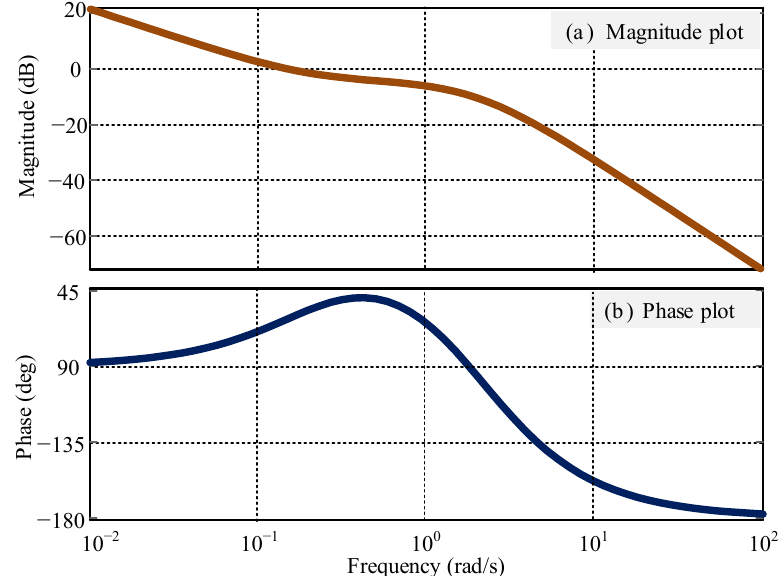
Figure 13. Stress voltage waveforms of the IGBTs and diodes used in the proposed transformer-less inverter: ( a ) S 1 , ( b ) S 2 , ( c ) S 3 , ( d ) S 4 , ( e ) S 5 , ( f ) S 6 , ( g ) S 7 , ( h ) D 1 , ( i ) D 2 , ( j ) D 3 , ( k ) D 4 , ( l ) D 5 , and ( m ) D 6 .